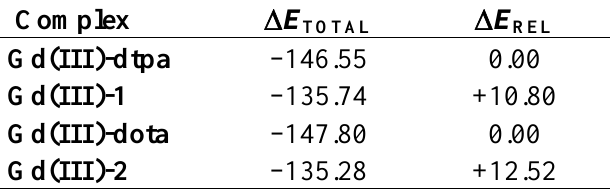
Table 3. Energy difference, ∆ E TOTAL = E COMPLEX – E LIGAND - E Gd(III) , and ∆ E REL , energy relative to the pattern complex (in kcal/mol, DFT